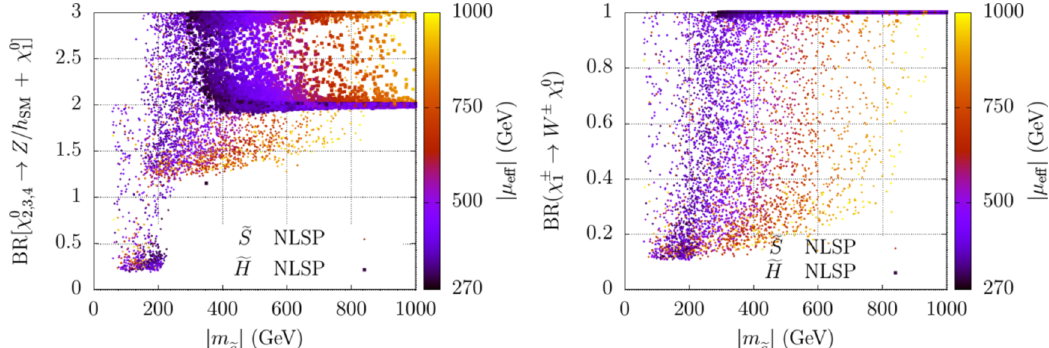
Figure 12 . Scatter plots (using the same set of points as in figure 11) presenting the combined branching ratio for the decays χ 0 (left) and the branching ratio for the decay → Z/h SM + χ 0 2 , 3 , 4 1 (right) as functions of | m χ ± → W ± χ 0 | . Values of | µ eff | are indicated via color palettes. The 1 1 e S dominant nature of the NLSP (singlino-like or higgsino-like) is represented by two different point- types (‘ ’ or ‘ ’, respectively) as shown by the legends at the bottom of the •